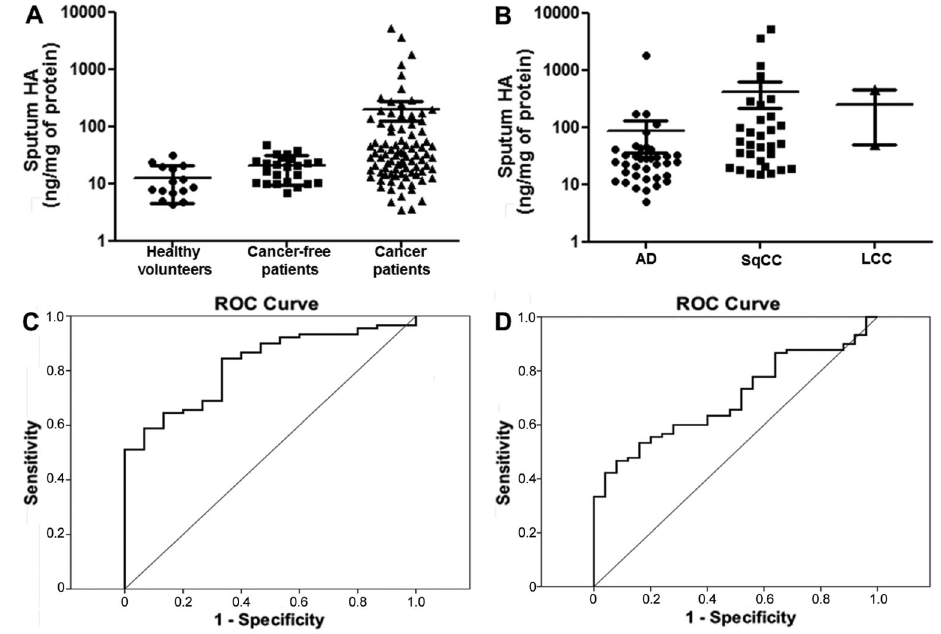
Figure 2. A , Box plots of hyaluronan (HA) in healthy volunteers, cancer-free patients and lung cancer patients (LC). Patients with lung cancer had significantly higher HA levels in sputum than in the cancer-free patients and healthy volunteers (Log10 scale; P , 0.001, Mann-Whitney test). B , Box plots of HA in lung cancer patients. Patients with squamous cell carcinoma (SqCC) had higher HA levels compared to adenocarcinoma (AD) and large cell carcinoma (LCC) (log10 scale; P , 0.001, Kruskal-Wallis test). C , D , Receiver operating characteristic (ROC) curves for sputum levels of HA. C , The cut-off level of HA that resulted in the highest diagnostic accuracy was . 31.44 ng/mg. This cut-off point discriminated between healthy controls and lung cancer patients, with 100% specificity and 51% sensitivity. The diagnostic accuracy was 82%. D , The cut-off level of HA that discriminated cancer-free patients and lung cancer patients with 100% specificity and 33% sensitivity was . 48.3 ng/mg. The diagnostic accuracy was